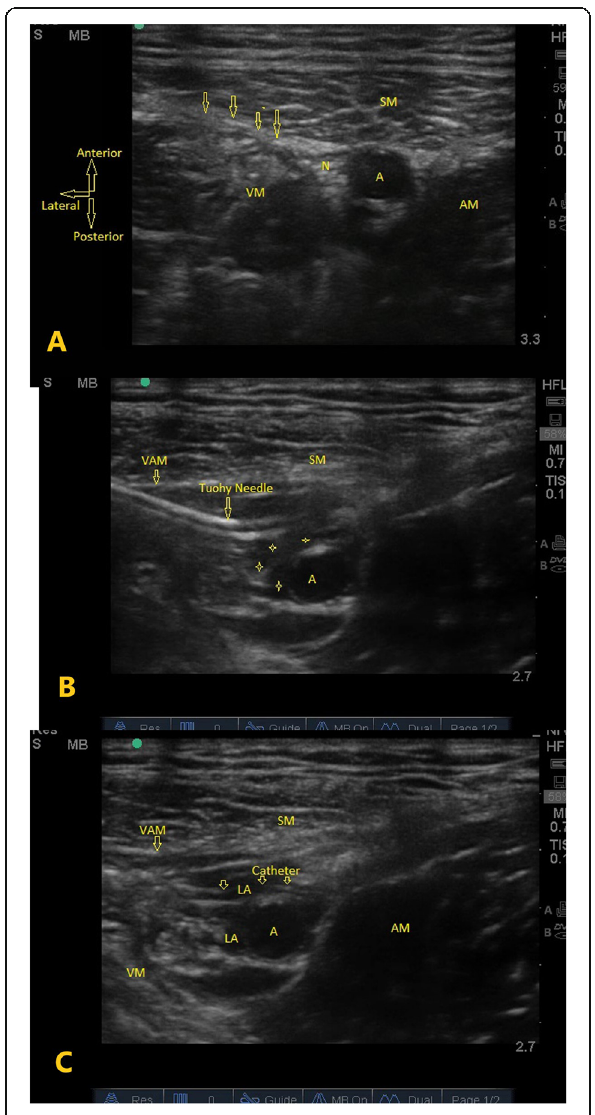
Fig. 2 a Sonoanatomy and identification of deep femoral artery in the adductor canal. b Correct spread of saline in the adductor canal (around the artery). c 20 G epidural catheter in the adductor canal. A-deep femoral artery, LA-local anesthetic, AM-adductor magnus muscle, SM- sartorius muscle. VAM-vaso-adductor membrane, VM- vastus medialis